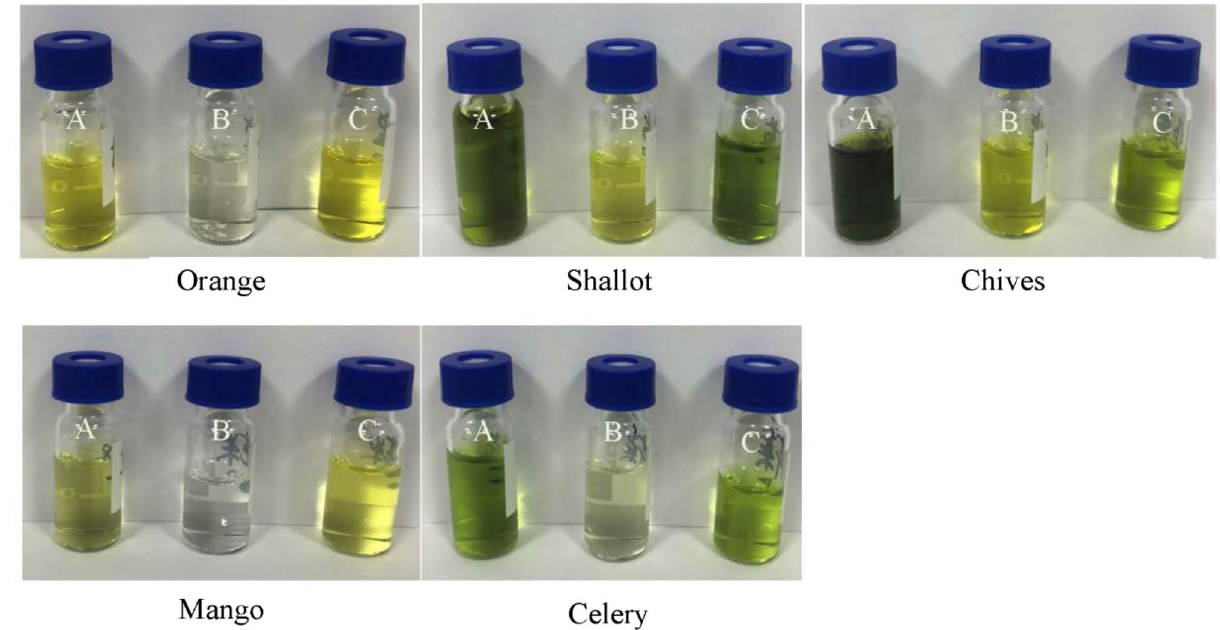
Figure 7. Different purification materials to remove pigment ( A ) without cleanup materials, ( B ) multiwalled carbon nanotubes, ( C ) PSA.